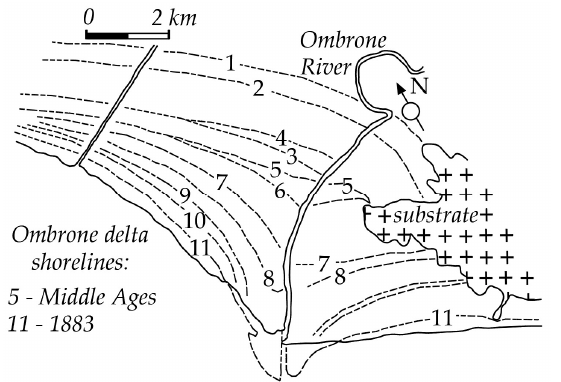
Figure 13. Progradation of the Ombrone River delta and shoreline changes (1–11) [38].